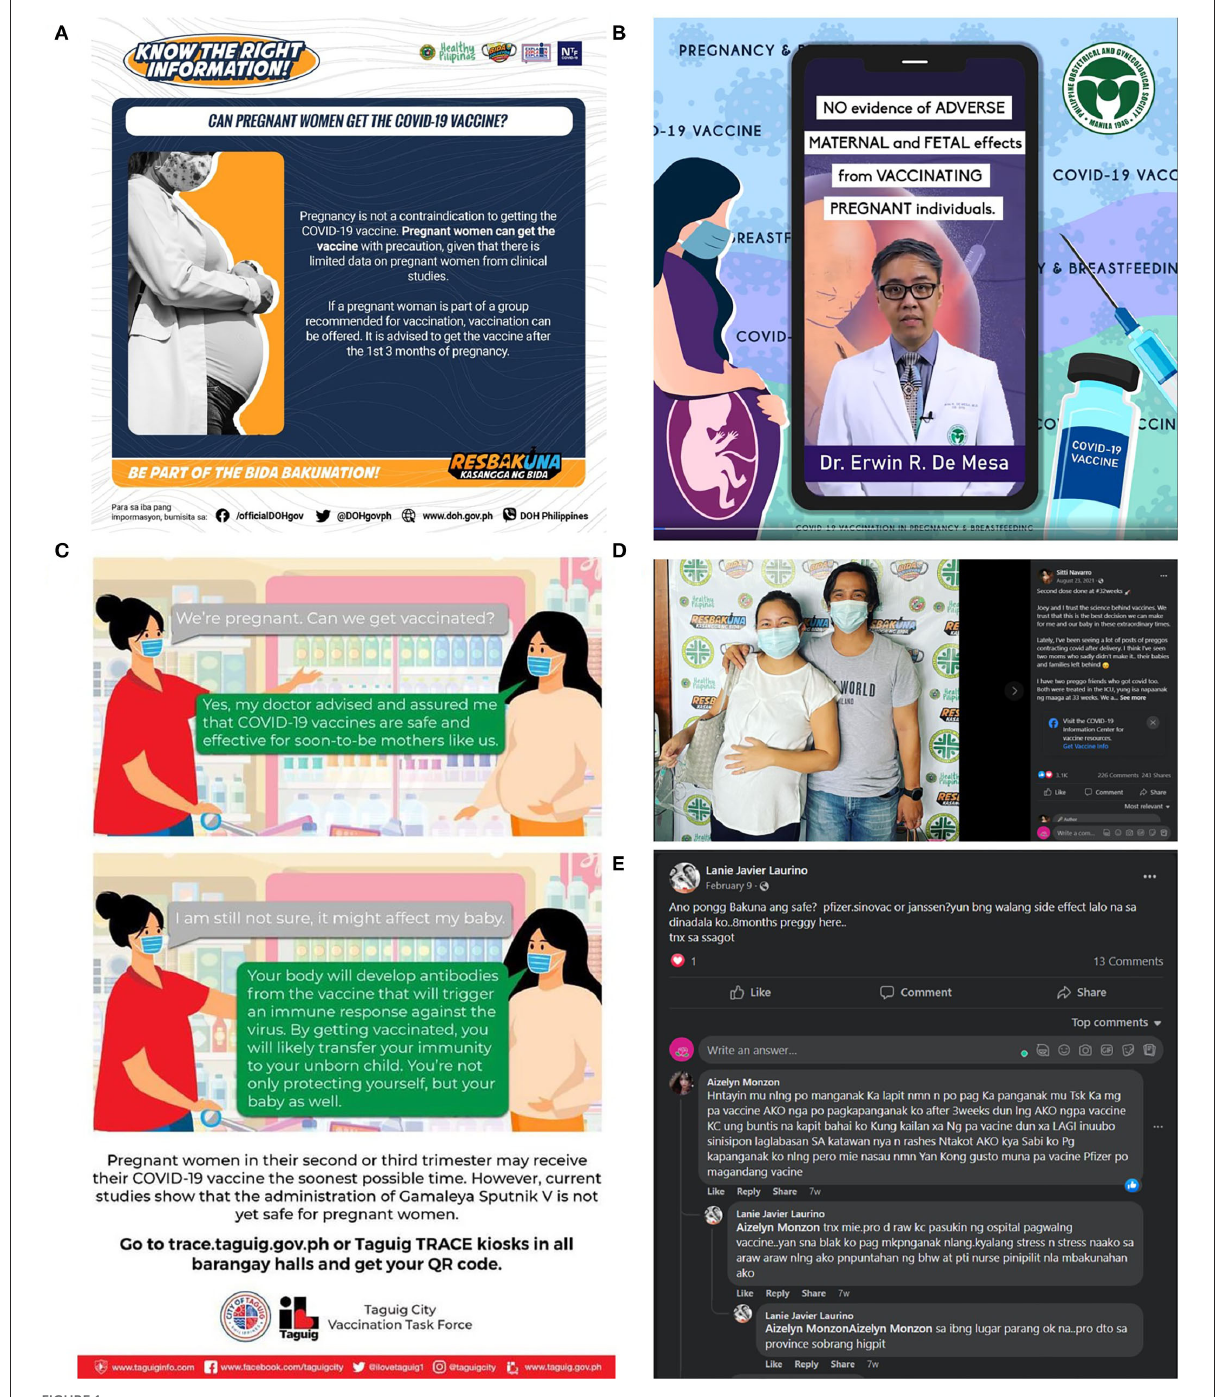
FIGURE1 Informational materials from (A) the Philippine Department of Health (DOH) Facebook page (Facebook, 2022a), (B) the Philippine Obstetrics and Gynecological Society (POGS) video (23-s screenshot), (C) a local government unit (Taguig), (D) post in Sitti’s Facebook profile that promotes vaccination, and (E) post in the Usapang Nanay publicly-accessible Facebook page that discourages COVID-19 vaccination during pregnancy (Facebook,